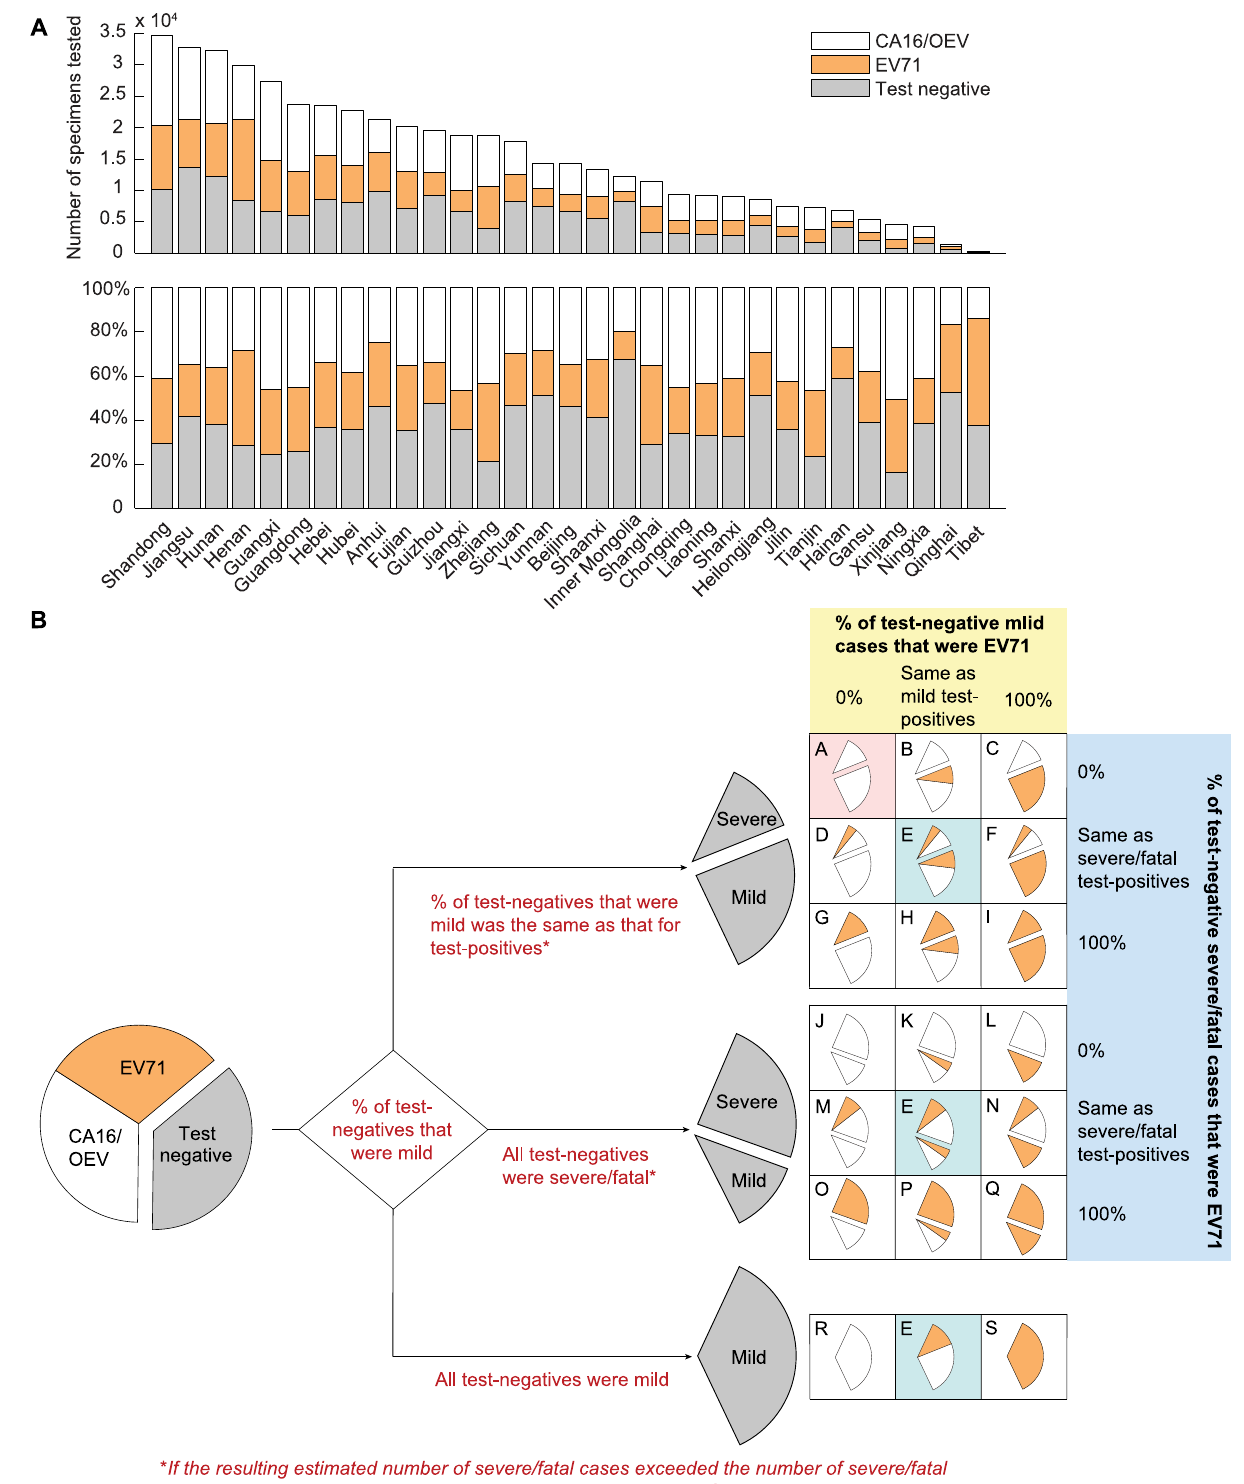
Fig 2. Estimating the percentage of mild and severe HFMD cases attributed to EV71 in China. (A) The number of specimens tested and the distribution of test results in each of the 31 provinces during 2010 – 2013. (B) Twenty-one scenarios were generated by making assumptions regarding the percentage of test-negative cases that were mild during 2010 – 2012 (the first branching point; annotated in red text) and the percentage of test-negative mild and